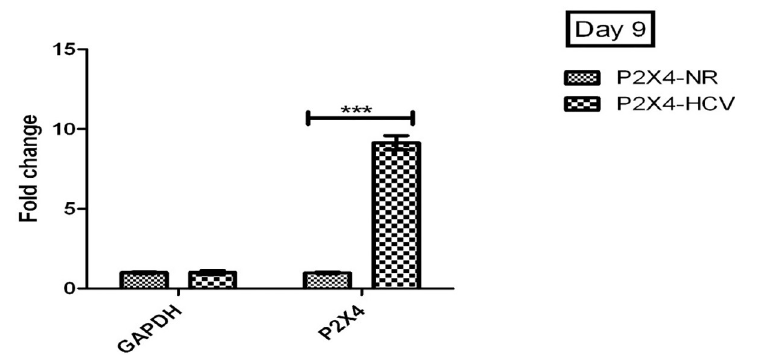
Fig 12. Expression of P2X4 gene at day 9 of post infection. All values are expressed as mean ± SEM, � P � 0.05 vs. control P2X4-NR cells.